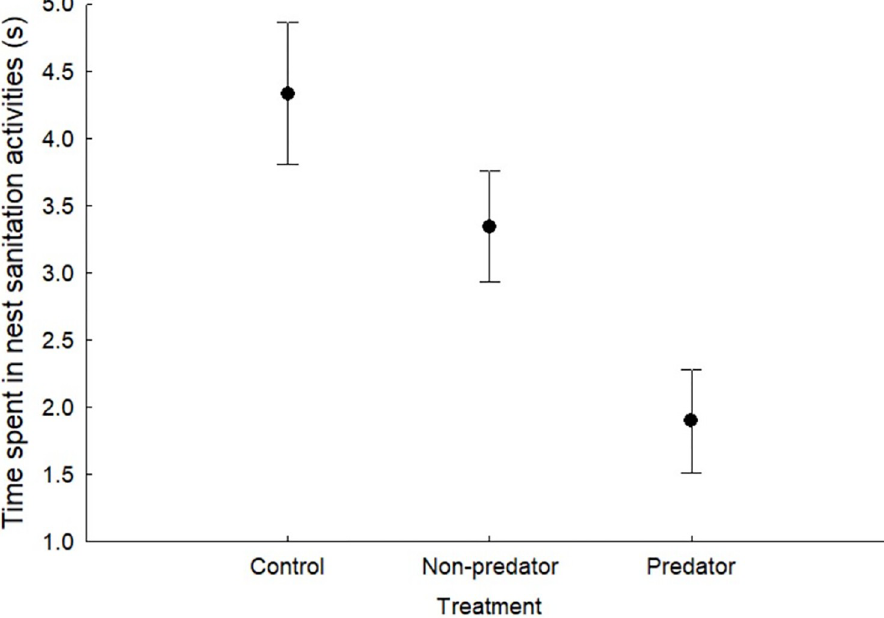
Fig 1. Mean ± SE time devoted to nest sanitation activities by blue tit females in relation to treatment: Control, non-predatory mammal (rabbit), and predatory mammal (mustelid) chemical cues placed inside the nest-box. Figure shows Box-Cox transformed